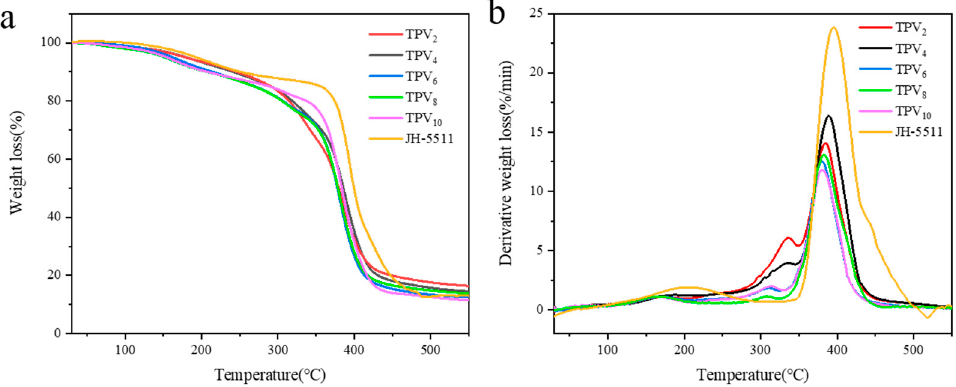
Figure 7. TG and DTG curves of TPVs. ( a ) TG curves, ( b ) DTG curves.